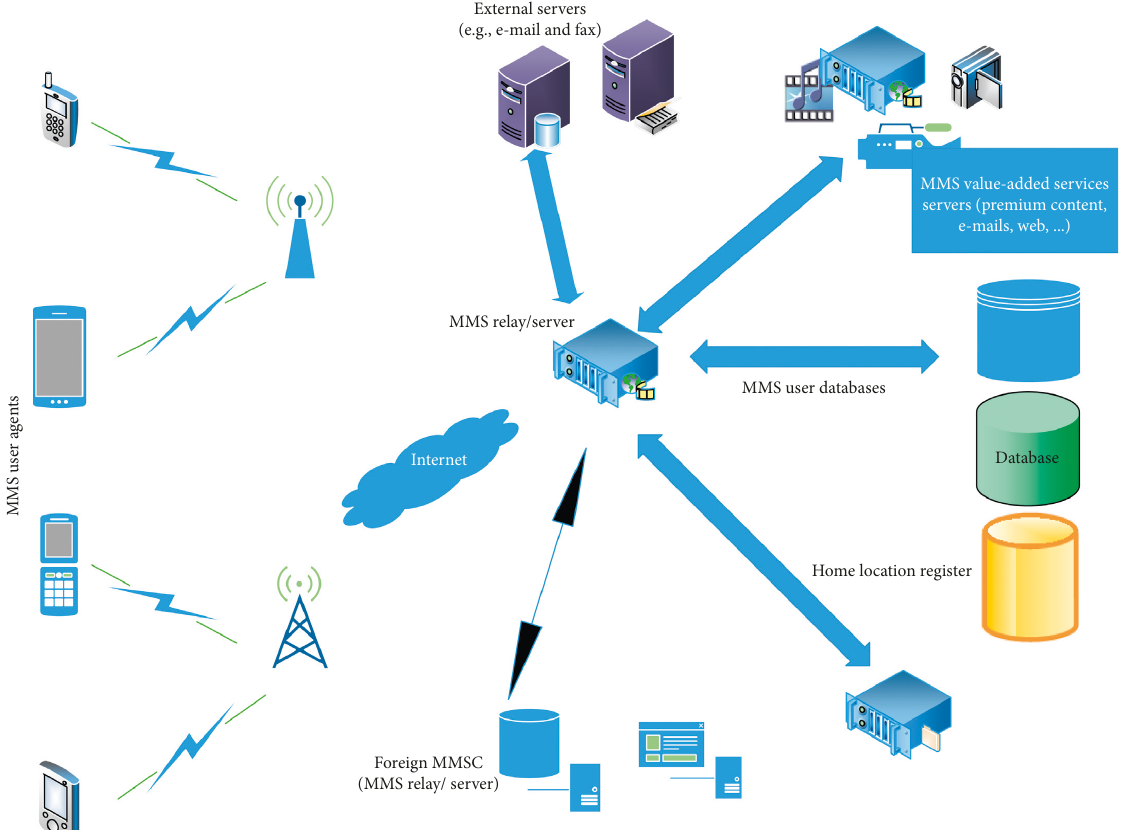
Figure 2: Example of the multimedia service architecture in the context of